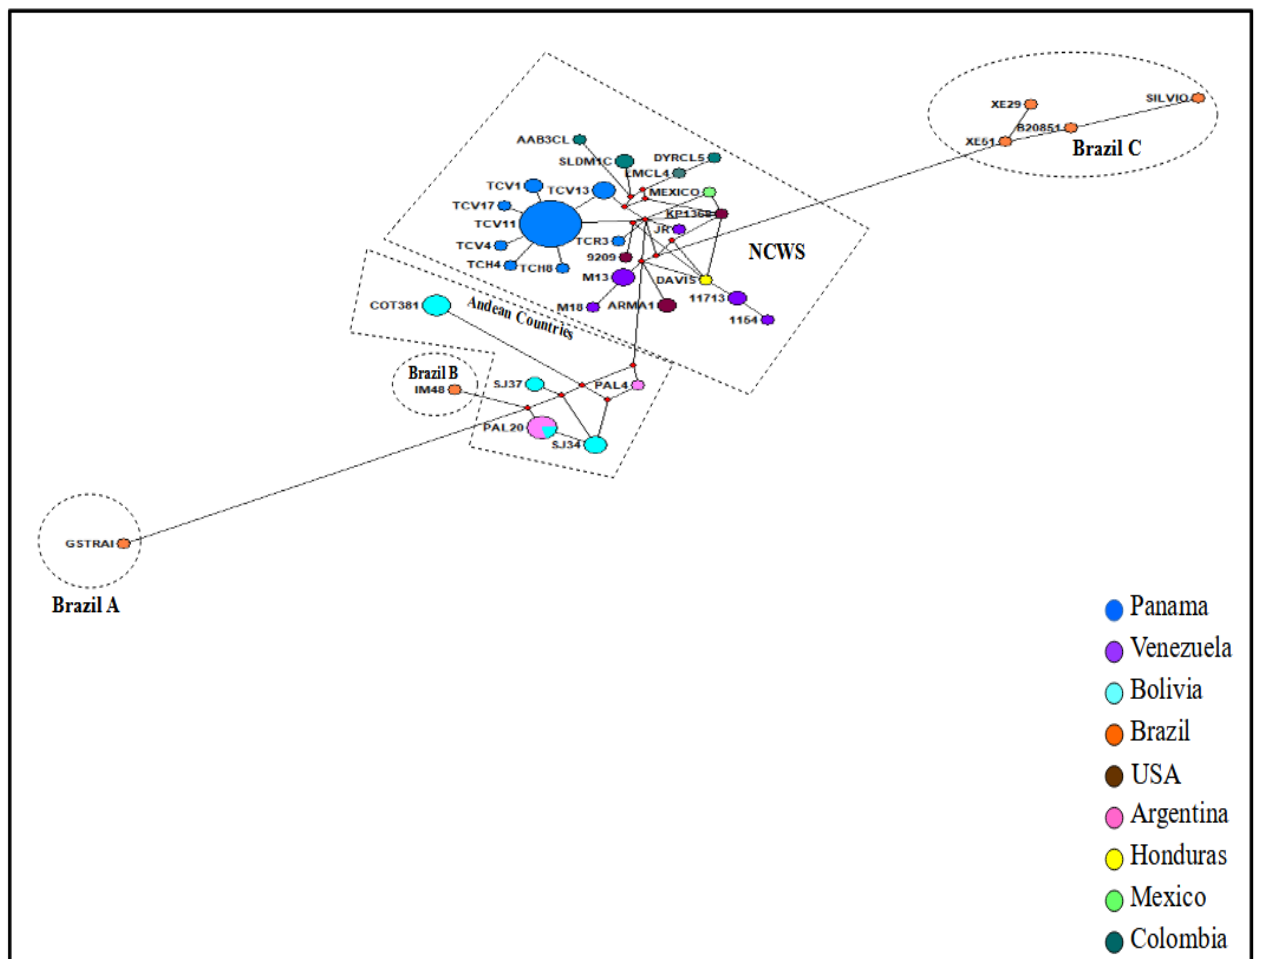
Figure 4. Haplotype network inferred by a median-joining method using concatenated mitochondrial sequences of six loci (ND1, COII, MURF1, CYT b, 12S rRNA and 9S rRNA) from 69 Trypanosoma cruzi TcI isolates, 29 from Panama (blue circles) and 40 reference T. cruzi strains from different endemic countries across the Americas. Circles represent a unique sequence haplotype with the color denoting the country origin and the size of the circle accounting for its frequency. The lengths of the lines connecting the haplotypes refer to the distance of relatedness. The small red circle represents the median vector, which can be interpreted as an unsampled sequence or an extinct ancestral sequence. The five clusters (Brazil A, Brazil B, Andean Countries, NCWS and Brazil C) are enclosed within dashed lines.